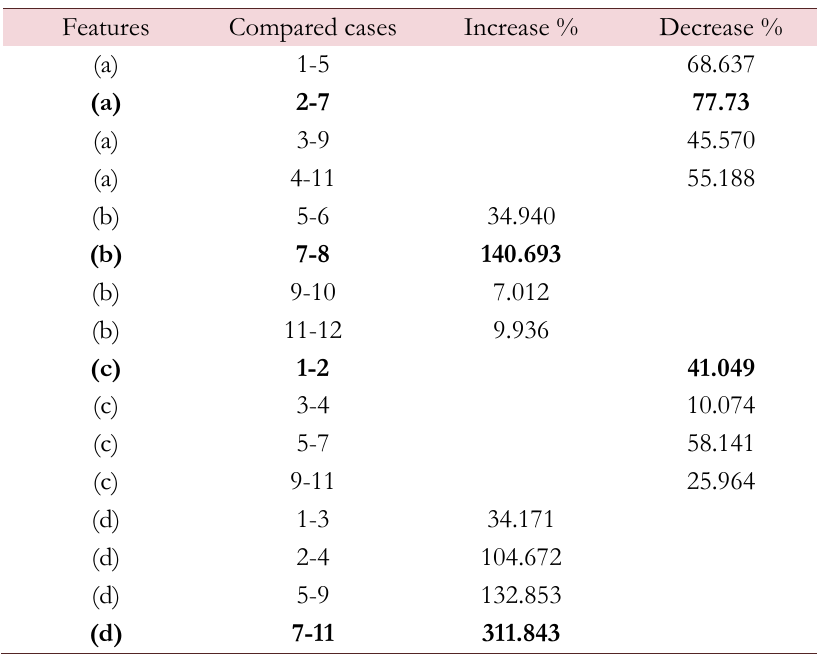
Table 2: Compared cases.